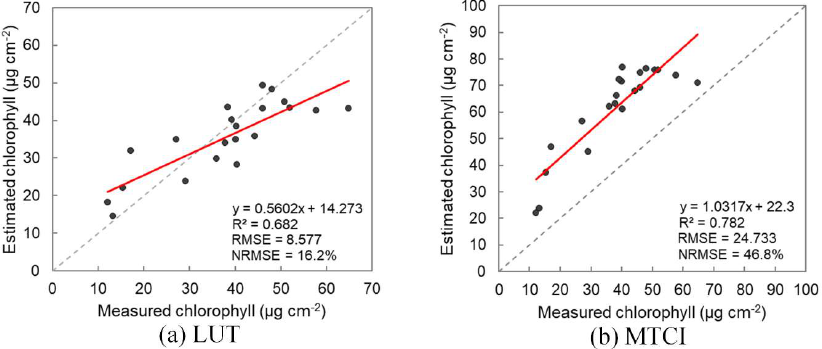
Figure 11. LCC retrieval performance for soybean using the LUT ( a ) and the MTCI ( b ) approaches